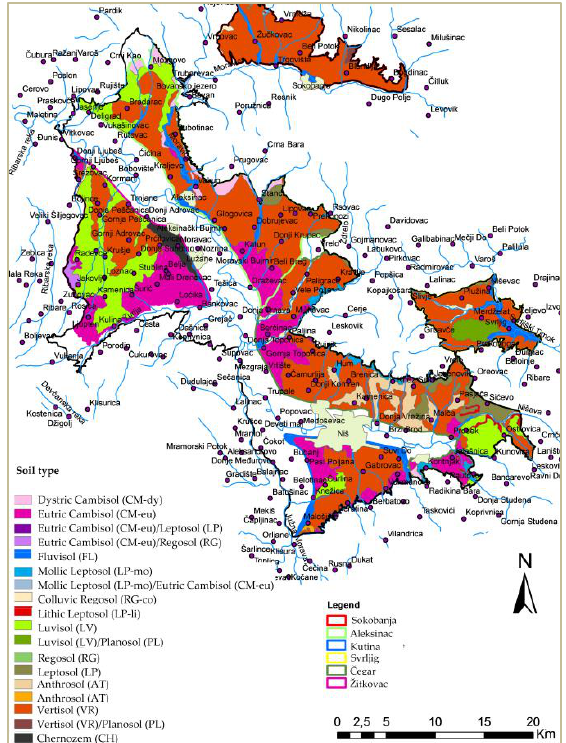
Figure 2. Pedological map of the wine-growing region of Niš and borders of vine-growing districts, according to the World Reference Base (WRB) soil classification; based on a digitalized primary pedological map of the Republic of Serbia, 1:50,000.